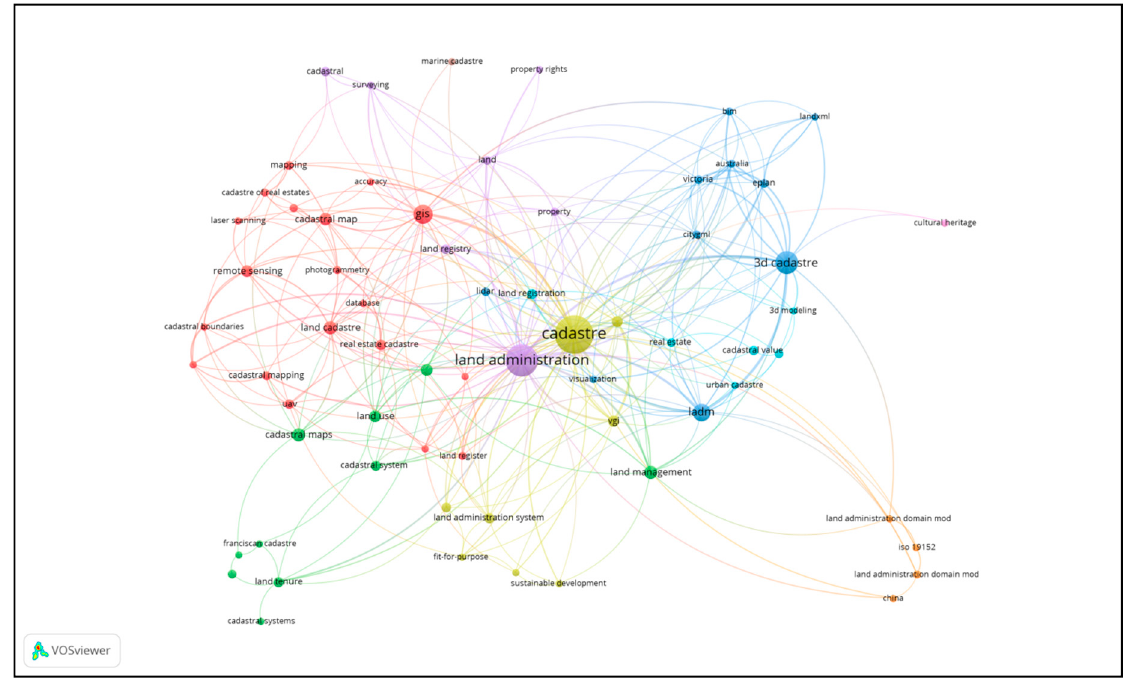
Figure 6. Keyword network map 2015–2019.